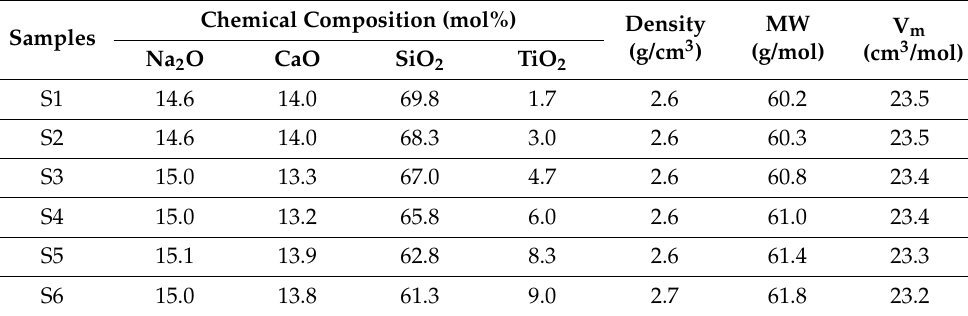
Figure 2. The 3D geometry described by the MCNP-5 input file. Table 1. Chemical composition of the glass samples.